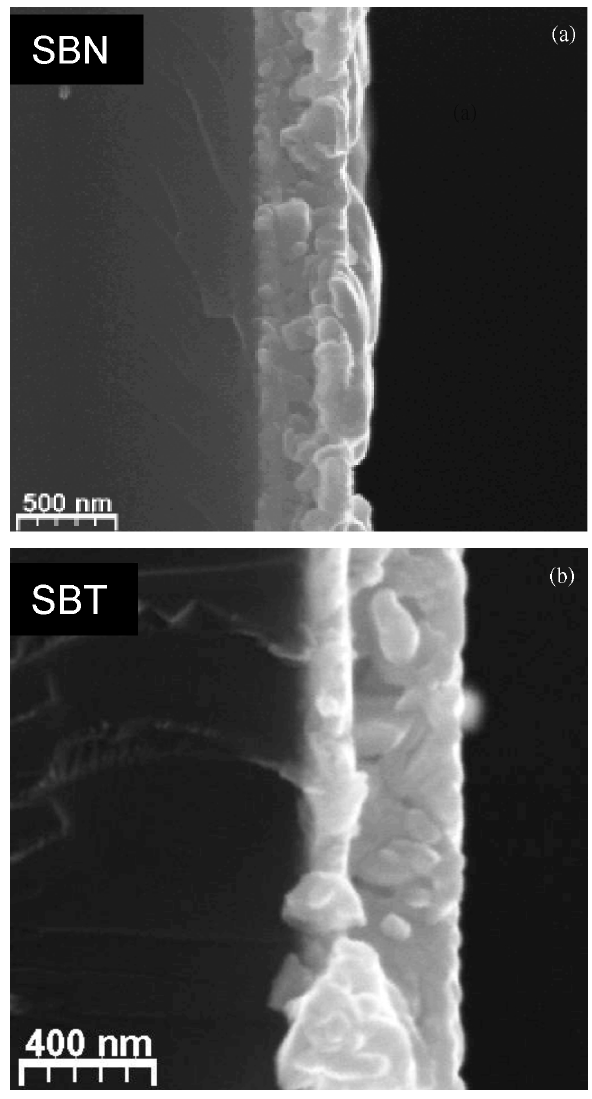
Figure5. SEMmicrographcrosssectionofthefilms:(a)SBNfilmtreated at 700 °C/2 h. Thickness = 395 nm; (b) SBT film treated at 750 °C/2 h. Thickness = 340